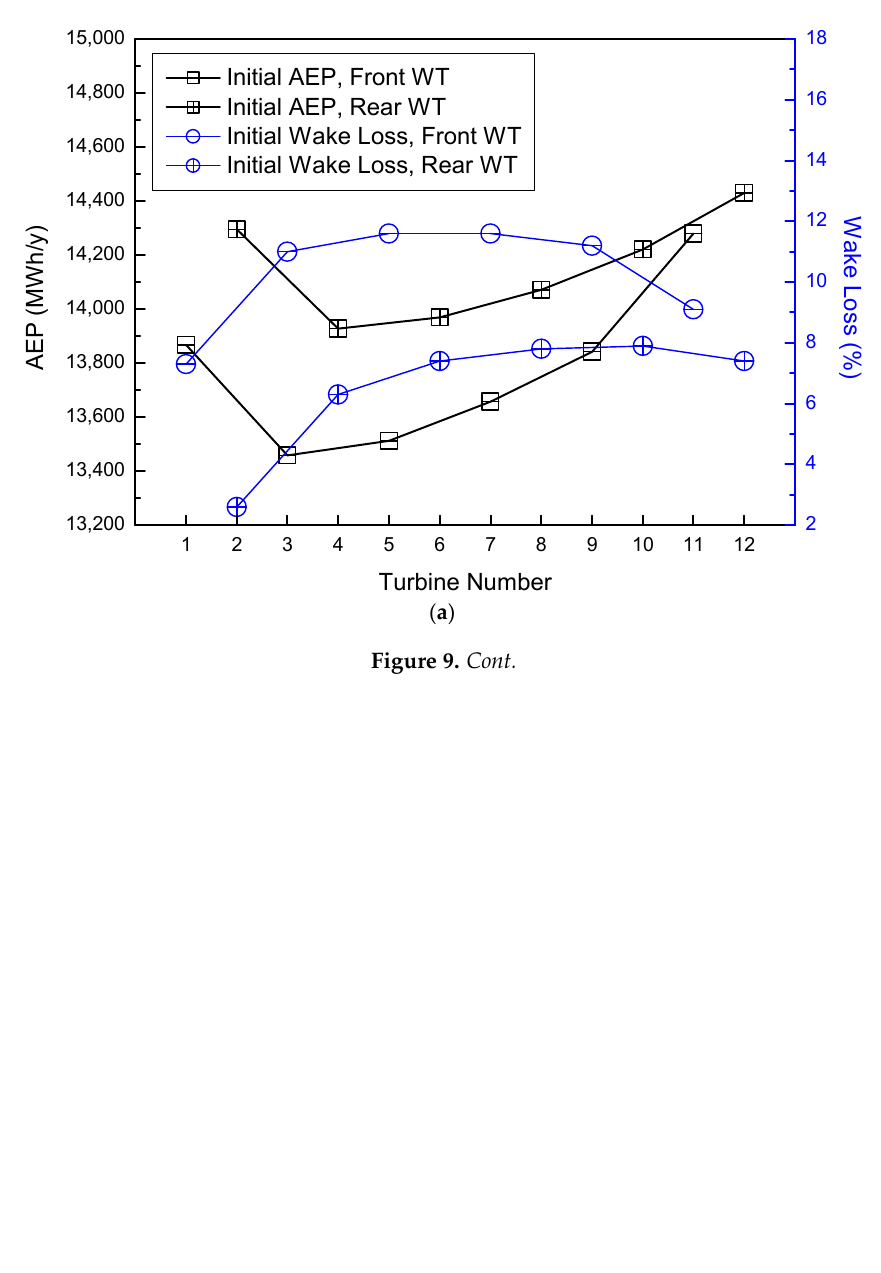
Figure 8. Optimal turbine layout for 12 WTGs (Wind Turbine Generators): ( a ) initial, ( b ) design of experiment ( DOE) best solution ( c ) optimal solution.